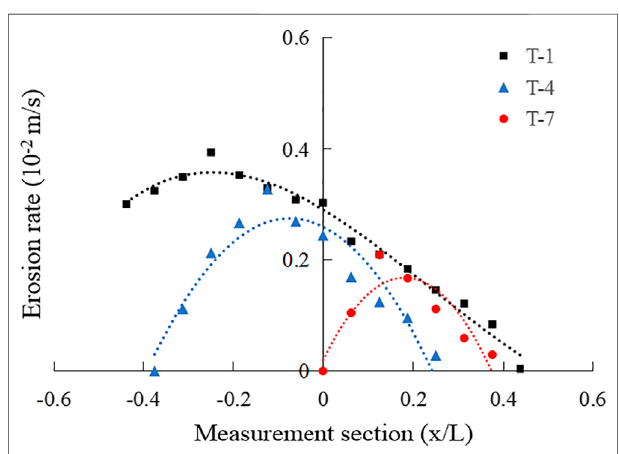
FIGURE 7 | Erosion rate at different measurement sections with time.